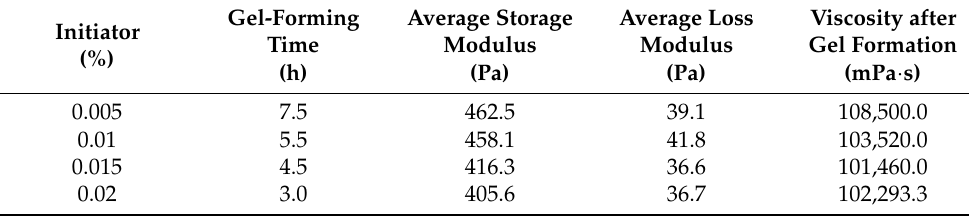
Table 3. The strength of the channel plugging system with initiator as variable.